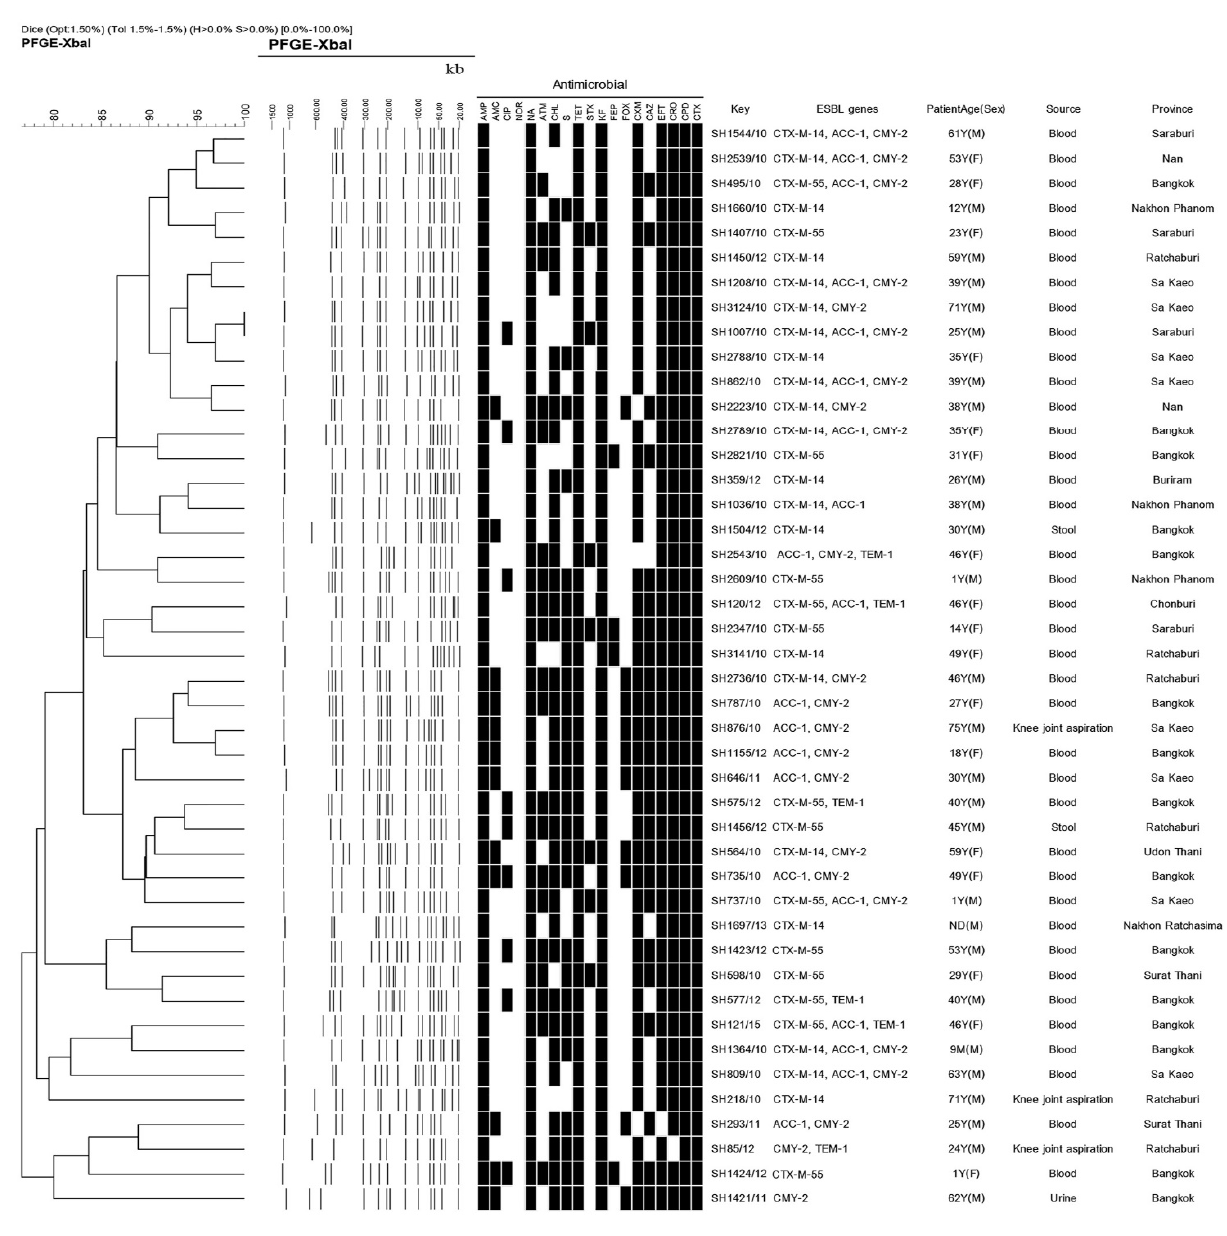
Figure 1. PFGE characteristics and ESBL genes of 44 ESBL-producing Salmonella Choleraesuis isolates.